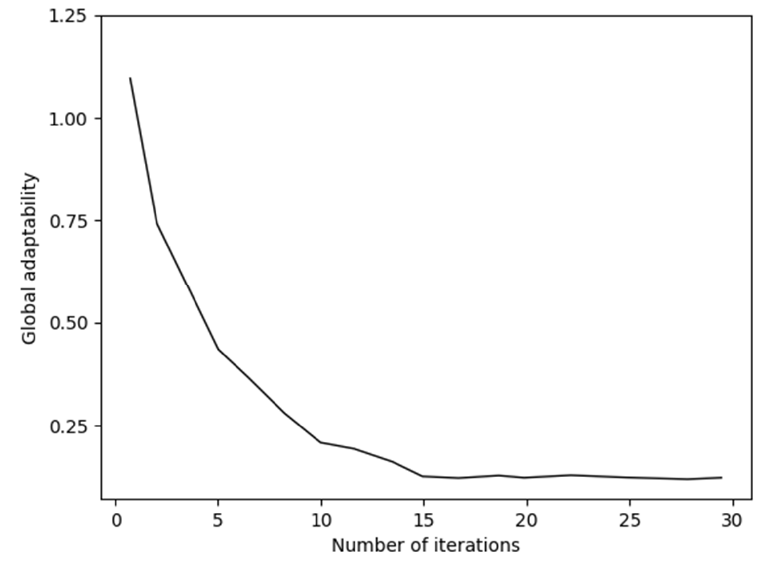
Figure 15. Effect of number of iterations on model performance.